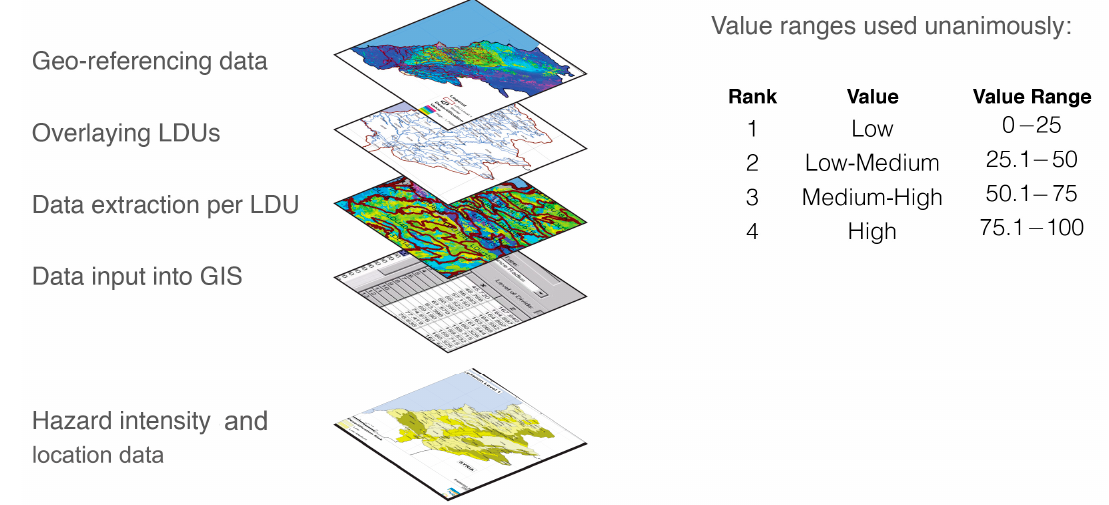
Figure 4. Hazard assessment methodology. LDU, landscape descriptive unit.